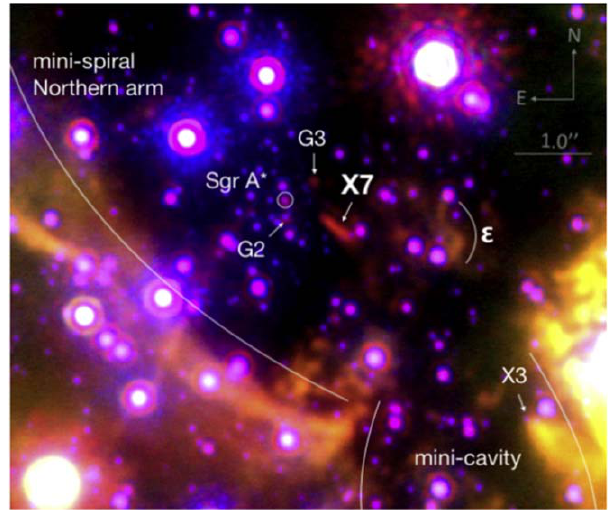
Figure 1. X7 in context: gas and dust structures in the Galactic Center. Three- color image of the central 0.27 × 0.27 pc of the Galactic Center obtained with the NIRC2 imager at the W. M. Keck Observatory. Lp ( 3.8 μ m ) is shown in red, Ms ( 4.7 μ m ) in green, and Kp ( 2.1 μ m ) in blue. All three bands were observed in summer 2021 using adaptive optics ( Section 2 provides details on these observations ) . Thermal emission from warm dust in X7 is well-detected at Lp ( 3.8 μ m ) . The source X3, originally thought to be of the same nature as X7 ( Mu ž i ć et al. 2007 ) , is also visible in the southwest corner. Other prominent, larger-scale features include the tip of the northern arm of the mini- spiral ( Lo & Claussen 1983 ) located to the south of X7, the top part of the mini- cavity ( Morris & Yusef-Zadeh 1987; Yusef-Zadeh et al. 1990 ) in the southwest, and the epsilon source ( Yusef-Zadeh et al. 1990 ) immediately east of